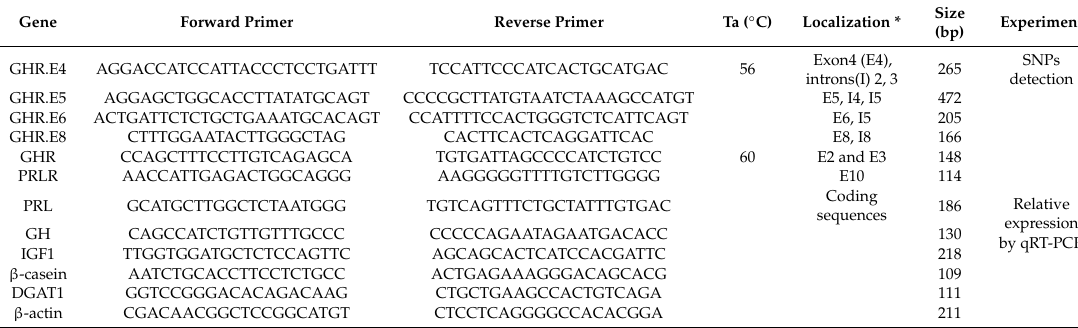
Table 1. Primers used in conventional and